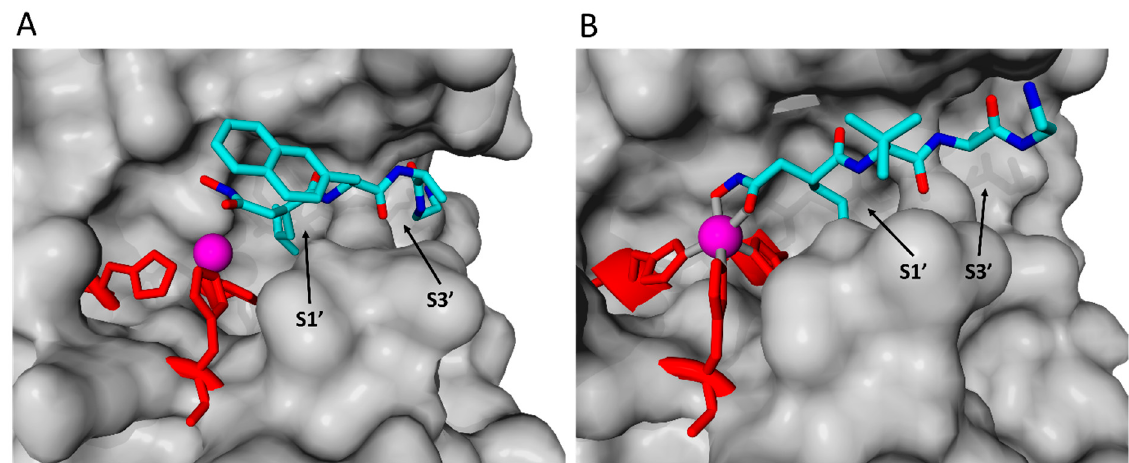
Figure 4. Comparison of docked TAPI-1 with cocrystallized TAPI-2 (2DDF). TAPI-1 ( A ) was docked in ADAM17 catalytic domain (Autodock vina & default parameters), while TAPI-2 ( B ) was cocrystallized in TACE (PDB: 2DDF [37]). Hydrogens were deleted after docking for better visual comparison. Zinc (magenta) was bound by three histidines (red) and hydroxymate group was positoned next to the zinc ion. Isobutyl group was binding in S1 ′ binding pocket, while rest of the inhibitor except of the naphtyl group was bound to S3 ′ .